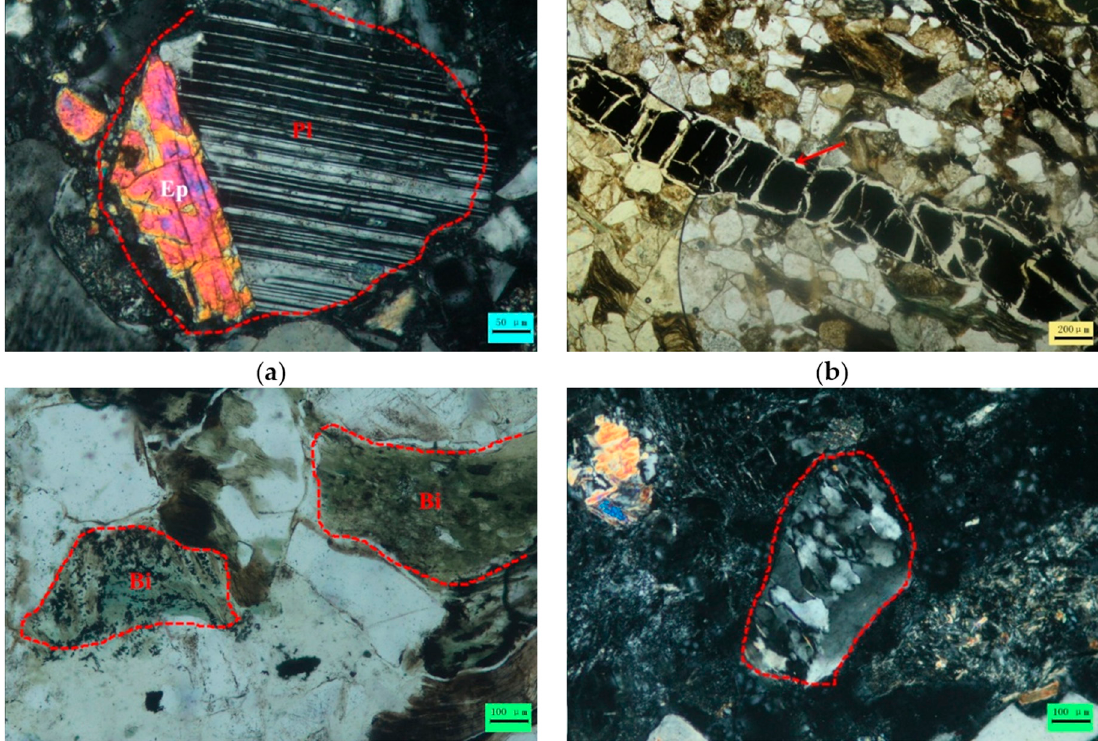
Figure 6. ( a ) (+) × 200 Epidote alteration of plagioclase; ( b ) ( − ) × 50 Carbon debris preserved plant stems; ( c ) Photo2-3 ( − ) × 100 Local chlorite alteration of biotite; ( d ) Photo2-4 (+) × 100 Quartz schist debris. (+) means crossed polars light; ( − ) means single polar